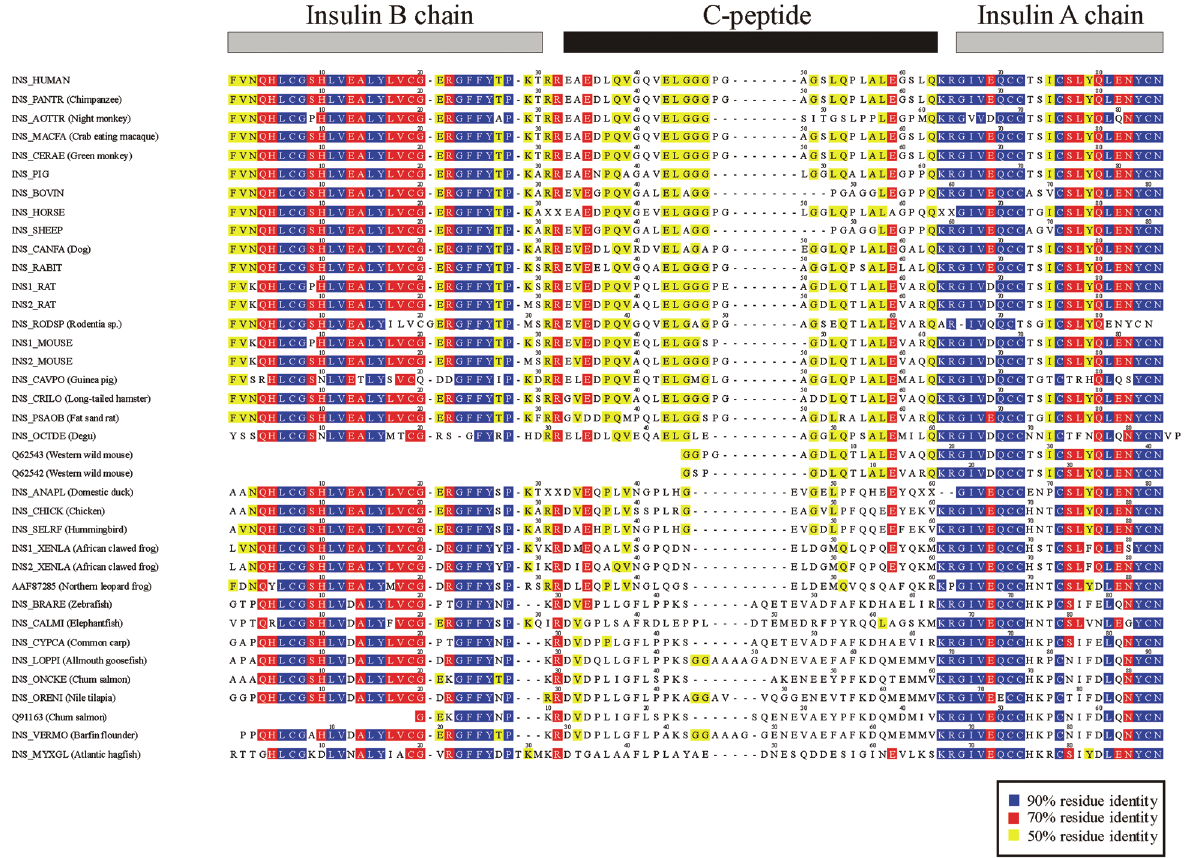
Figure 1 An alignment of proinsulin sequences from mammals, birds, amphibians and fish illustrates the comparatively low conservation of the C-peptide part in relation to the A- and B chains of insulin. Glu3 and Glu27 (positions 35 and 59, respectively, in the human proinsulin sequence) represent the only well-conserved residues in C-peptide. [Reproduced with permission from Ref.